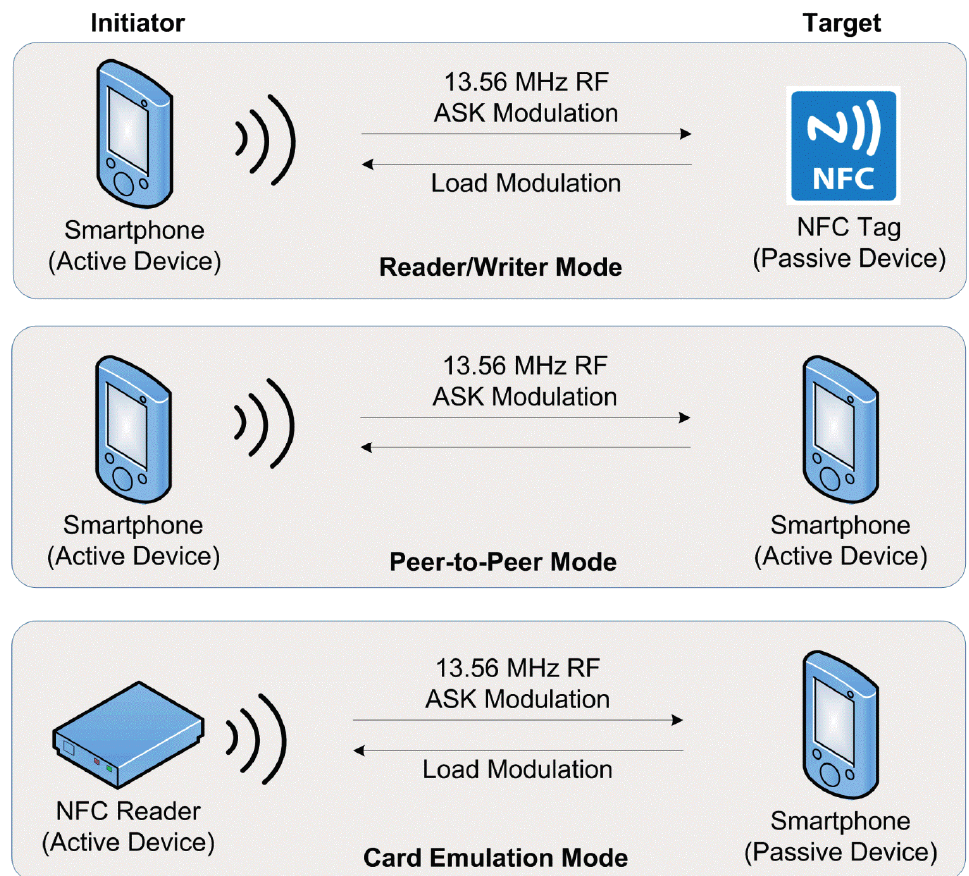
Figure 1. NFC interaction styles and operating